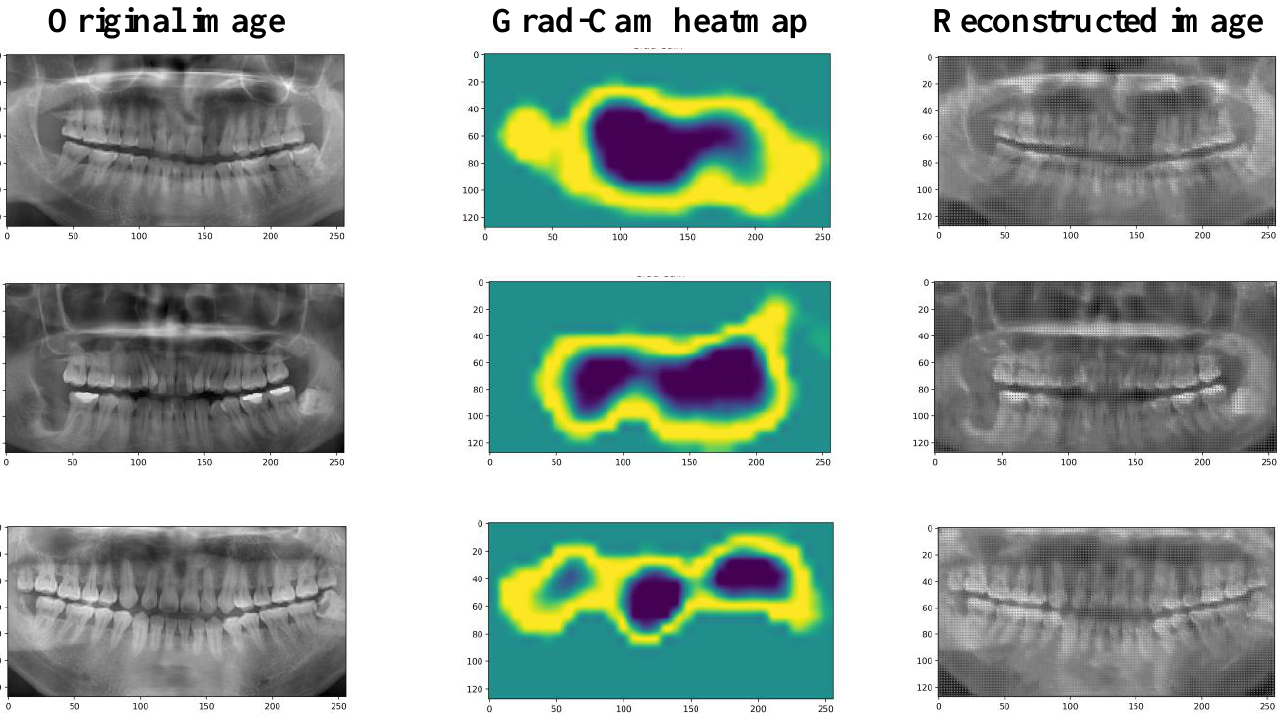
Figure 2. 2D projection of the latent space of the autoencoder. The red dots show OPGs with periodontitis and the grey dots reflect healthy samples.